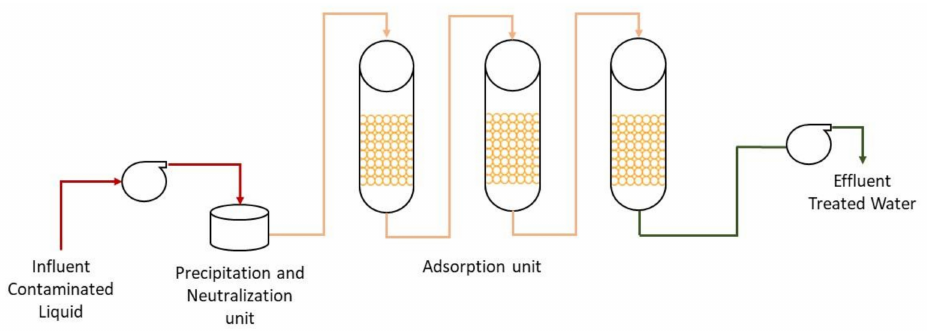
Figure 5. The general process involved in adsorption